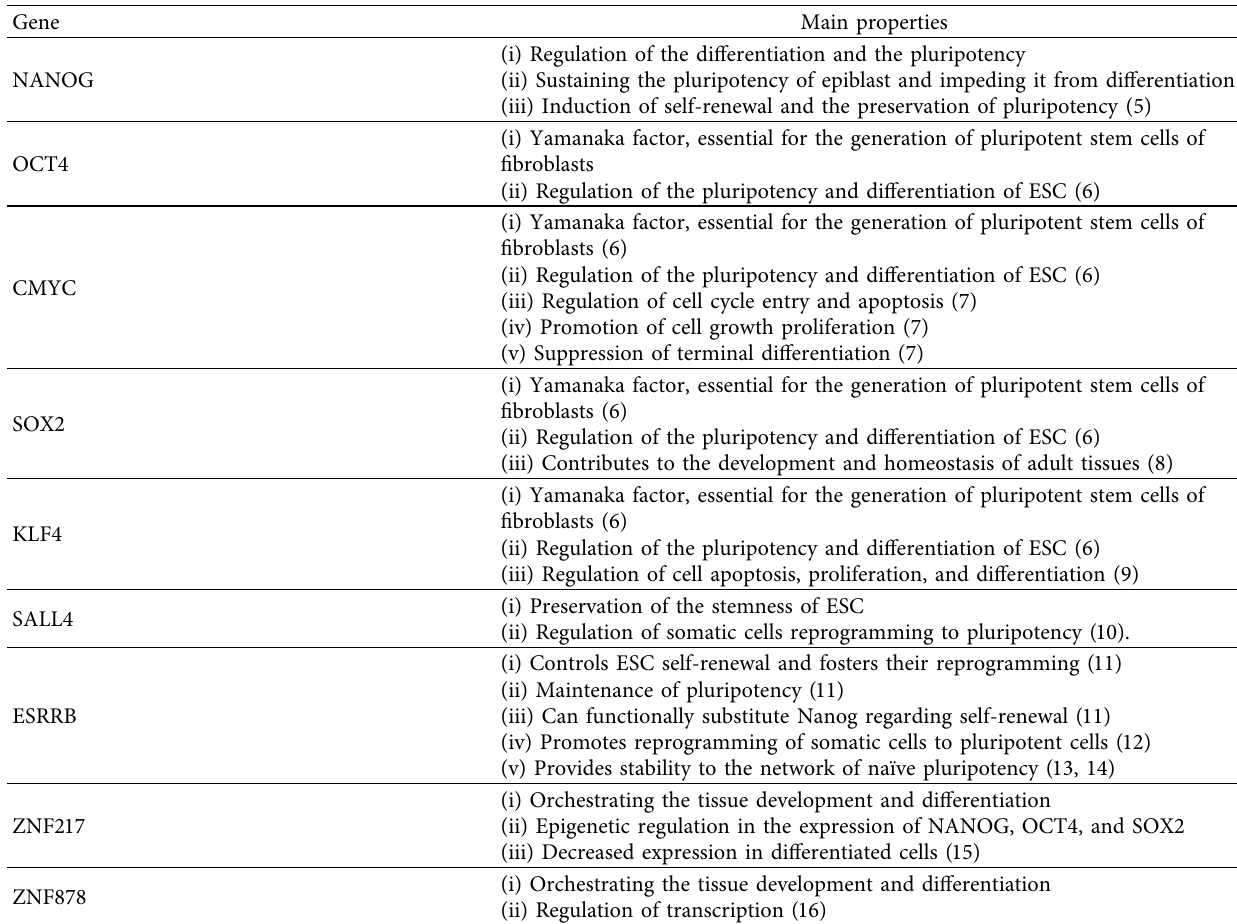
Table 1: Genes’ properties (main properties of genes that coincide with pluripotency) (ESC: embryonic stem cells). Gene Main properties